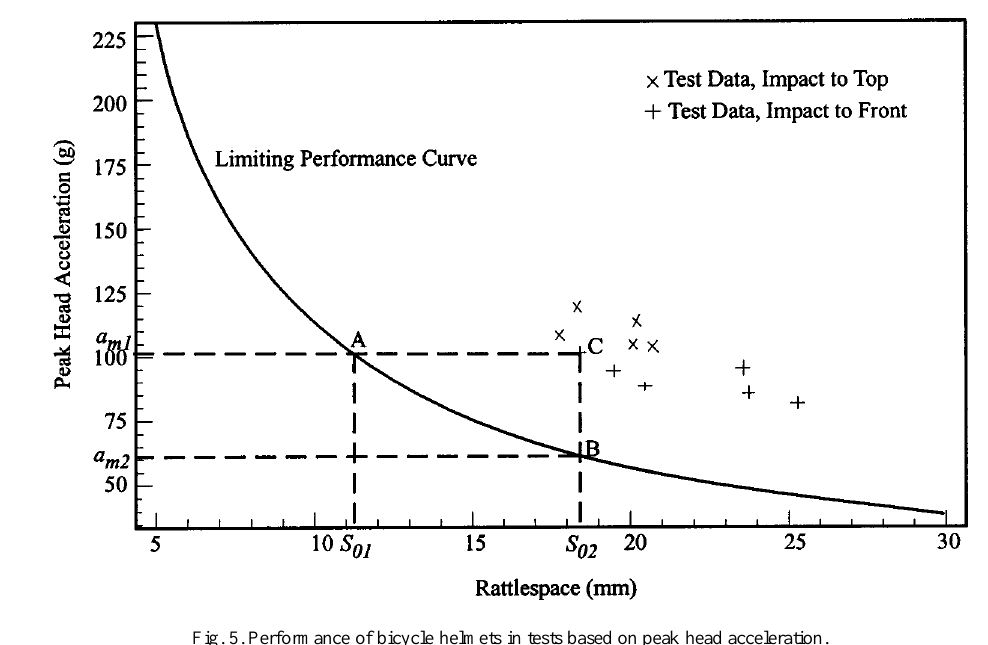
Fig. 5. Performance of bicycle helmets in tests based on peak head